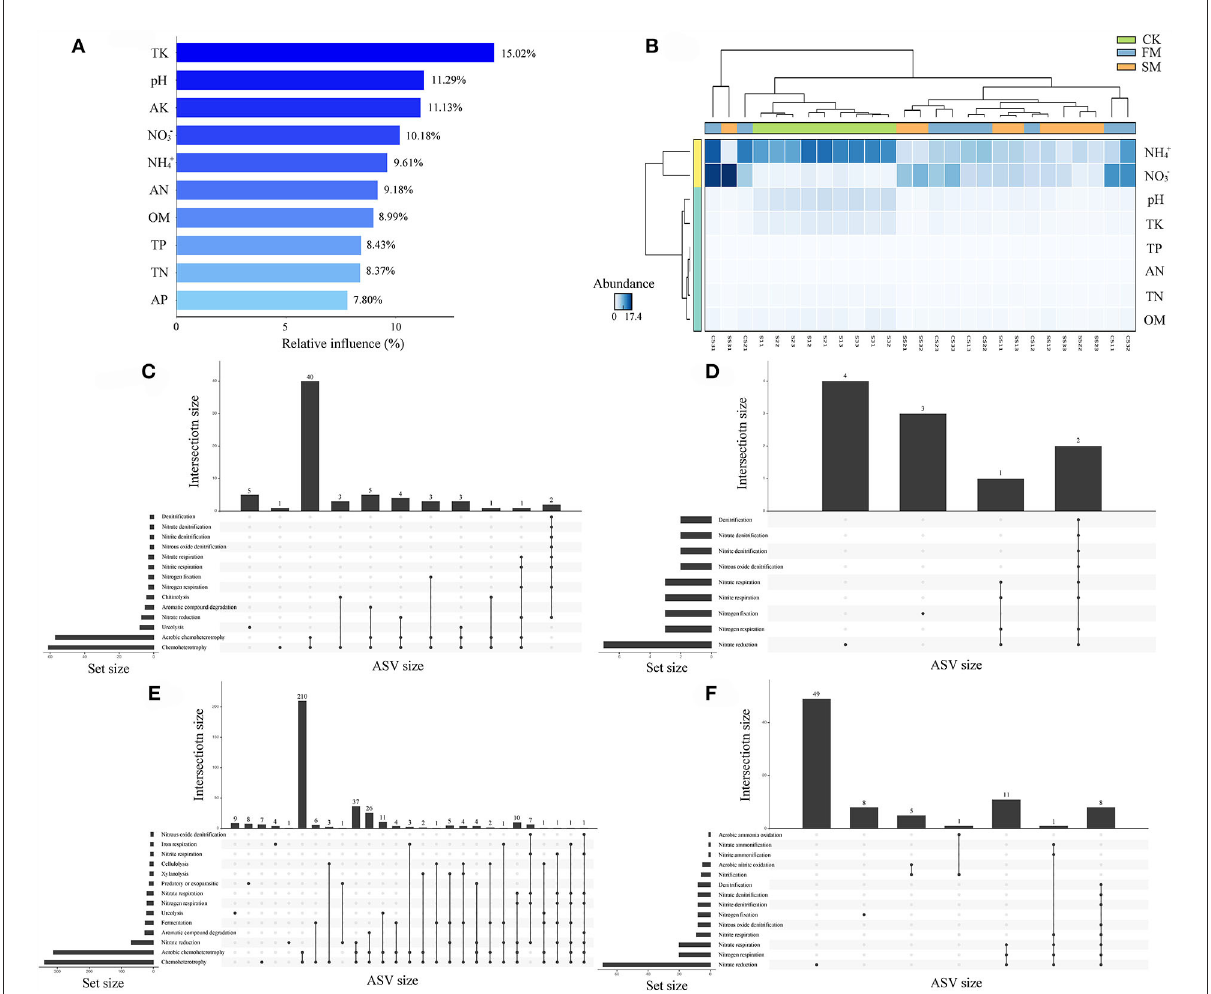
FIGURE4 The relationships between soil chemical properties and nitrogen-related functions under combined intensive management. (A) The relative influence (%) of predictor variables for Moso bamboo forests was calculated by the aggregated boosted tree model. (B) Heatmap revealing the relationship between soil chemical properties and different soil samples. (C–F) Upset results show the relationships of nitrogen-related functions on intensively managed soil bacteria predicted by FAPROTAX. The left panel displays the number of ASVs assigned to different functions. Dark circles in the matrix indicate sets of treatments that intersect. (C) Abundant ASVs (relative abundance > 0.1%); (D) Rare ASVs (relative abundance < 0.01%); (E) abundant ASVs related to nitrogen cycles; (F) rare ASVs related to nitrogen